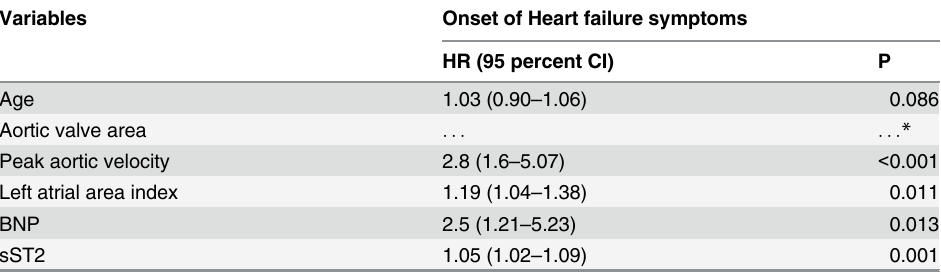
Table 3. Univariable data included in the multivariable outcome models in asymptomatic patients.